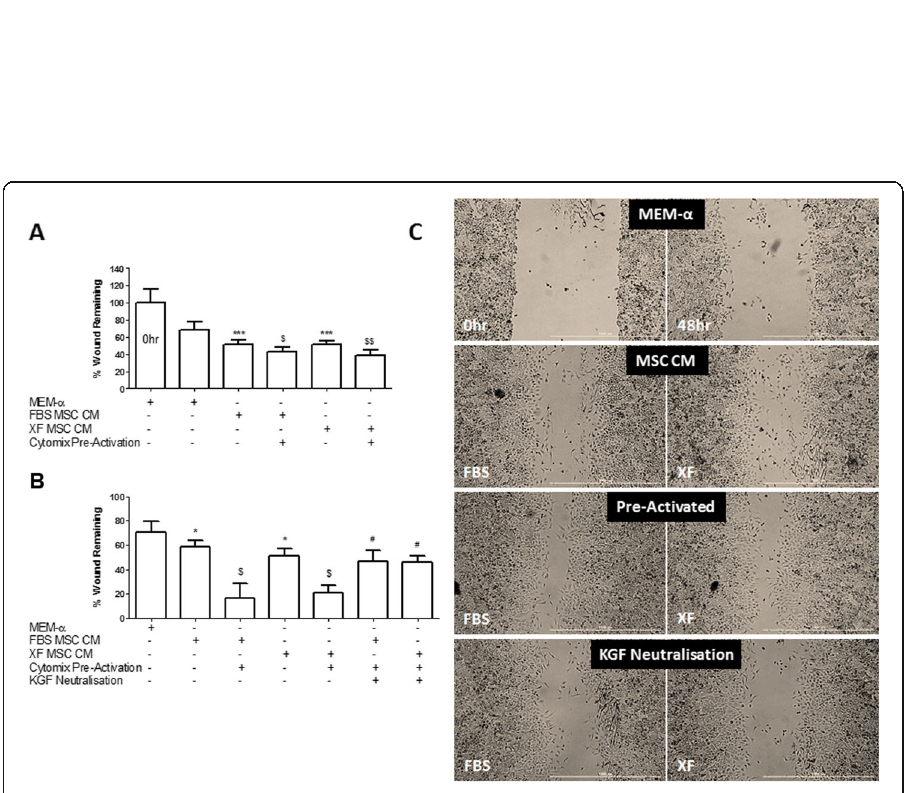
Fig. 5 Pre-activation enhances the efficacy of hMSC CM in promoting pulmonary epithelial wound healing. FBS-hMSC CM and XF-hMSC CM comparably enhanced wound repair in comparison with the MEM- α control ( a ). Pre-activation of these MSCs further enhanced the ability of the CM to improve wound repair but this was attenuated by KGF neutralization ( b ). Representative images are provided ( c ). Note: * and *** = P < 0.05 and 0.001 versus MEM- α ; and $ and $$ = P < 0.05 and 0.01, versus respective naive FBS or XF-hMSC CM; # = P < 0.05 versus respective pre-activated FBS or XF-hMSC CM. 0 h, n = 16; MEM- α control, n = 7 – 12; all other groups, n = 4 –